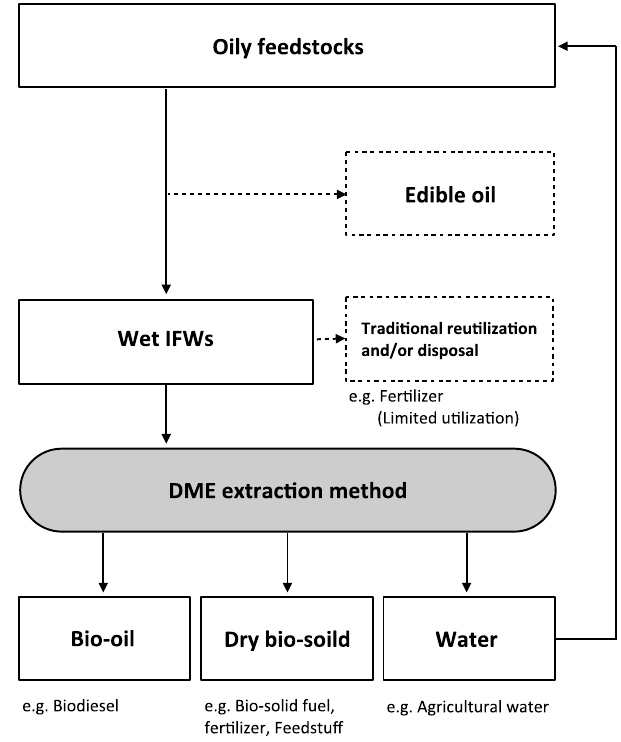
Figure 3. Proposed ( solid line ) and traditional ( broken line ) approaches for the disposal and reutilization of IFWs.